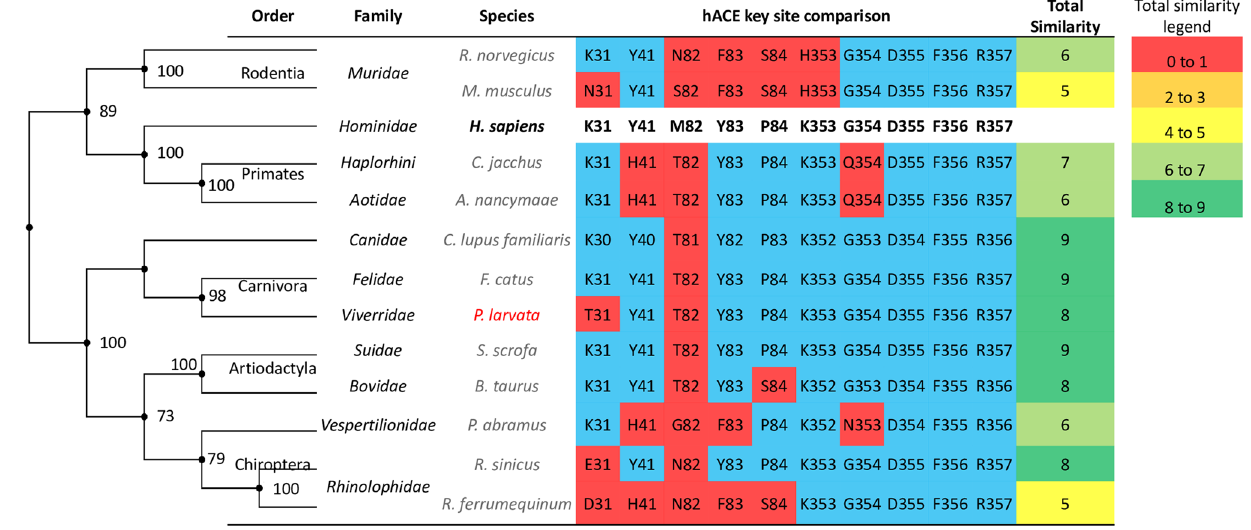
Figure 1. A sample comparison between mammalian ACE2 genes. Global similarities represented by whole ACE2 gene comparisons (the phylogenetic tree on the left) poorly predict mammals at high risk of being infected by SARS-CoV; whereas local similarities at key human ACE2 sites (the table on the right) show that species in the Carnivora, Artiodactyla and Chiroptera orders are at high risk of SARS-CoV infection. The tips of the phylogenetic tree are aligned with the corresponding species listed in the table. Species in red is the masked palm civet, a possible intermediate host of SARS-CoV. Species in black bold is human, and all other species are in grey. Amino acids highlighted in blue and red are matching and mis-matching sites, respectively, between mammalian ACE2 and human ACE2 at key SARS-CoV S protein binding sites. Total similarity in the table is calculated as the sum of matching amino acids between mammalian and human ACE2 at key binding sites. A comparison of key ACE2 sites involved in SARS-CoV binding between human and 131 mammals is shown in Supplementary Figure